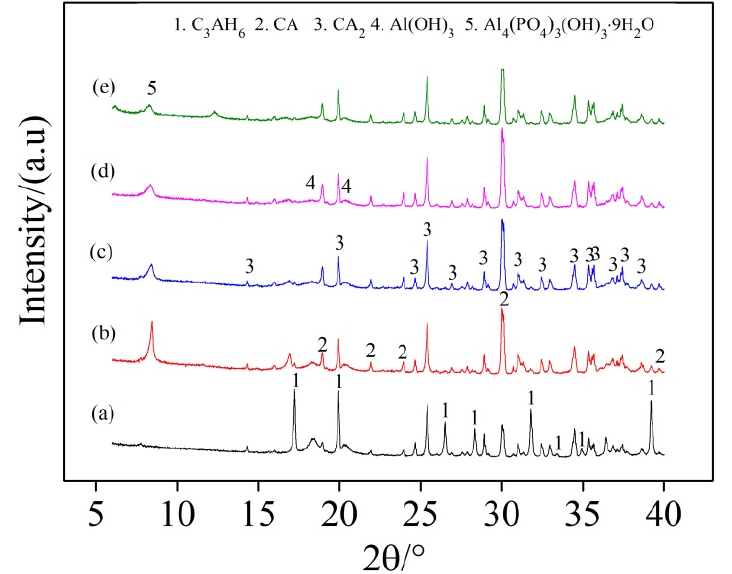
Figure 7. X-ray di ff raction (XRD) patterns of PCAC after 1 d hydration: (a) without SHMP, (b) with Figure 7. X-ray diffraction (XRD) patterns of PCAC after 1 d hydration: (a) without SHMP, (b) with 0.05% SHMP, (c) with 0.1% SHMP, (d) with 0.2% SHMP, and (e) with 0.4% 0.05% SHMP, (c) with 0.1% SHMP, (d) with 0.2% SHMP, and (e) with 0.4% SHMP.